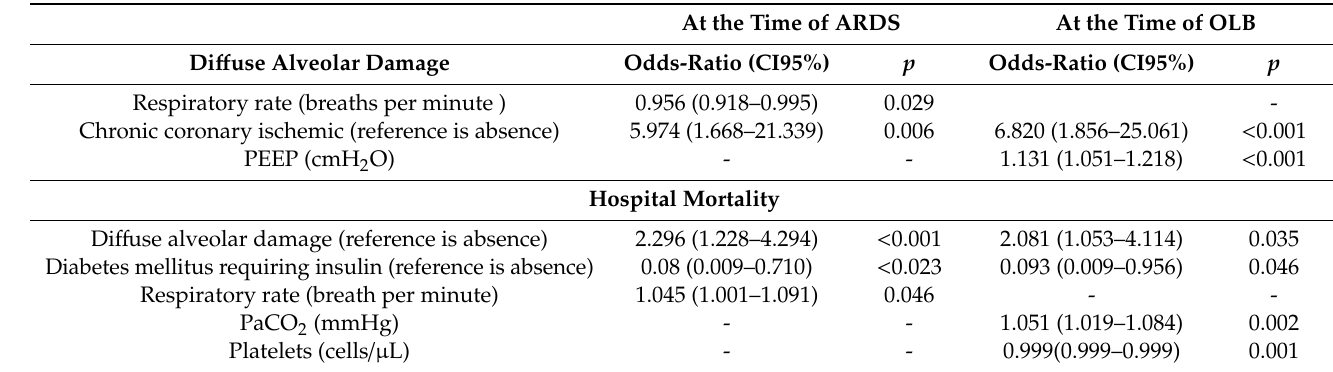
Table 5. Pooled logistic regression analysis to predict di ff use alveolar damage and hospital mortality. At the Time of ARDS At the Time of OLB Di ff use Alveolar Damage